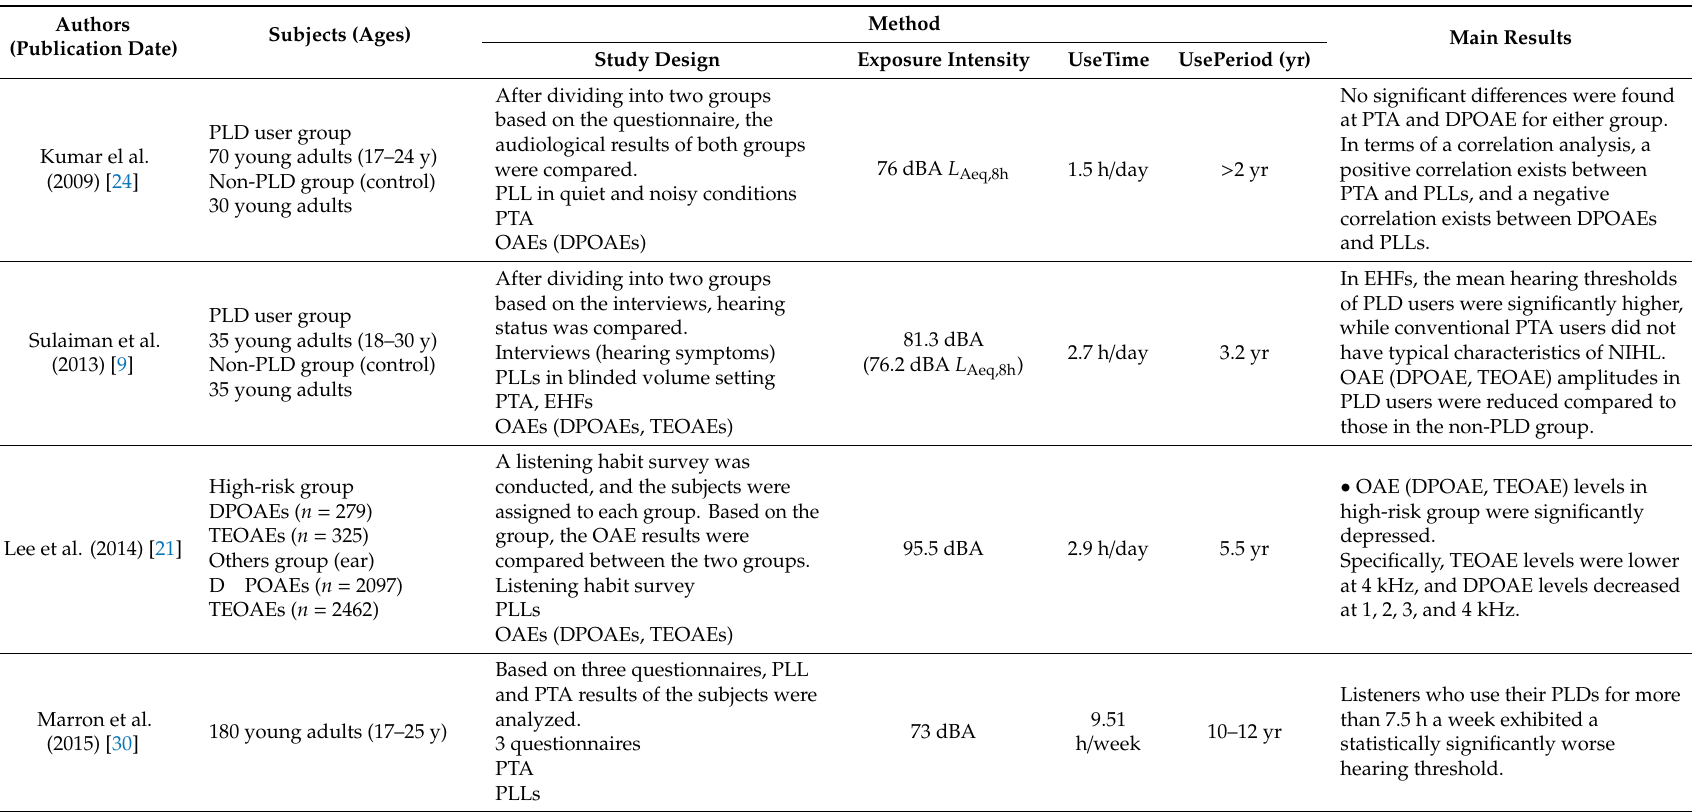
Table 4. Summary of studies showing long-term hearing changes included in the